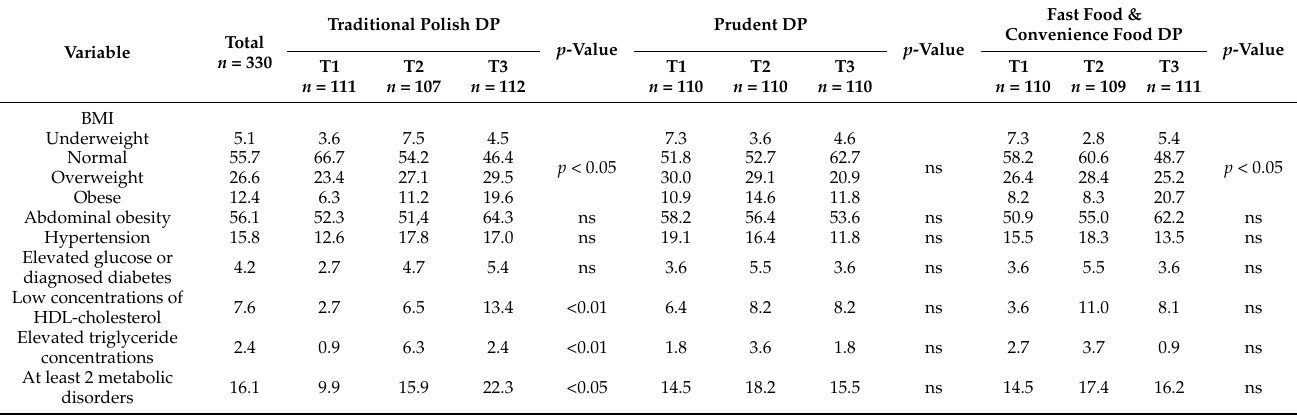
Table 5. Occurrence of adiposity and metabolic abnormalities (%) by adherence to the DPs in the study sample ( n =